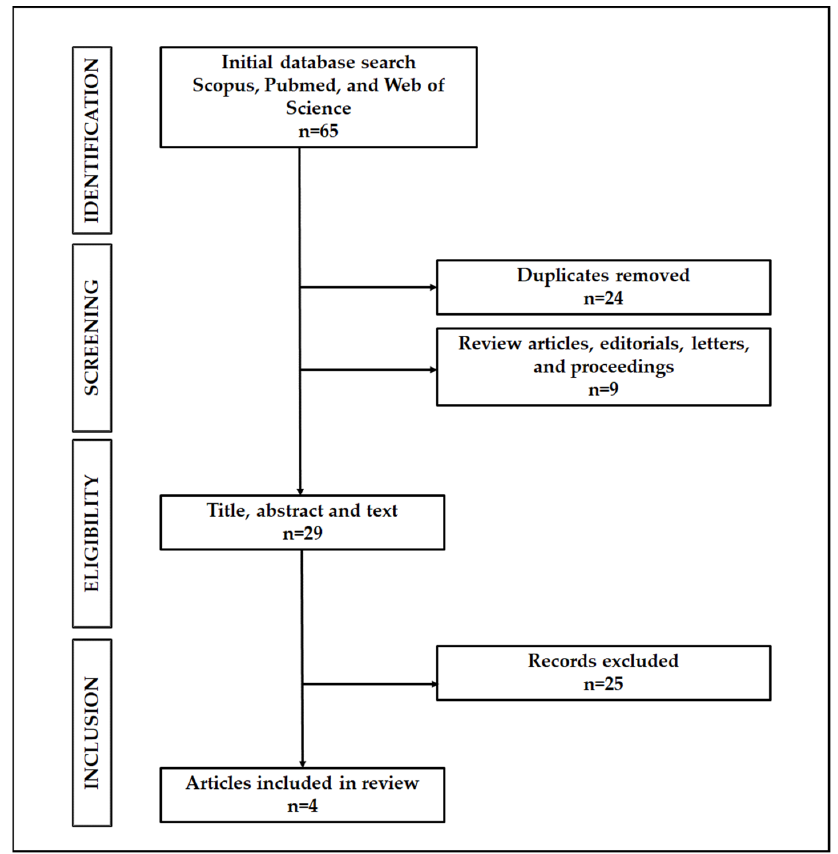
Figure 1. Search strategy